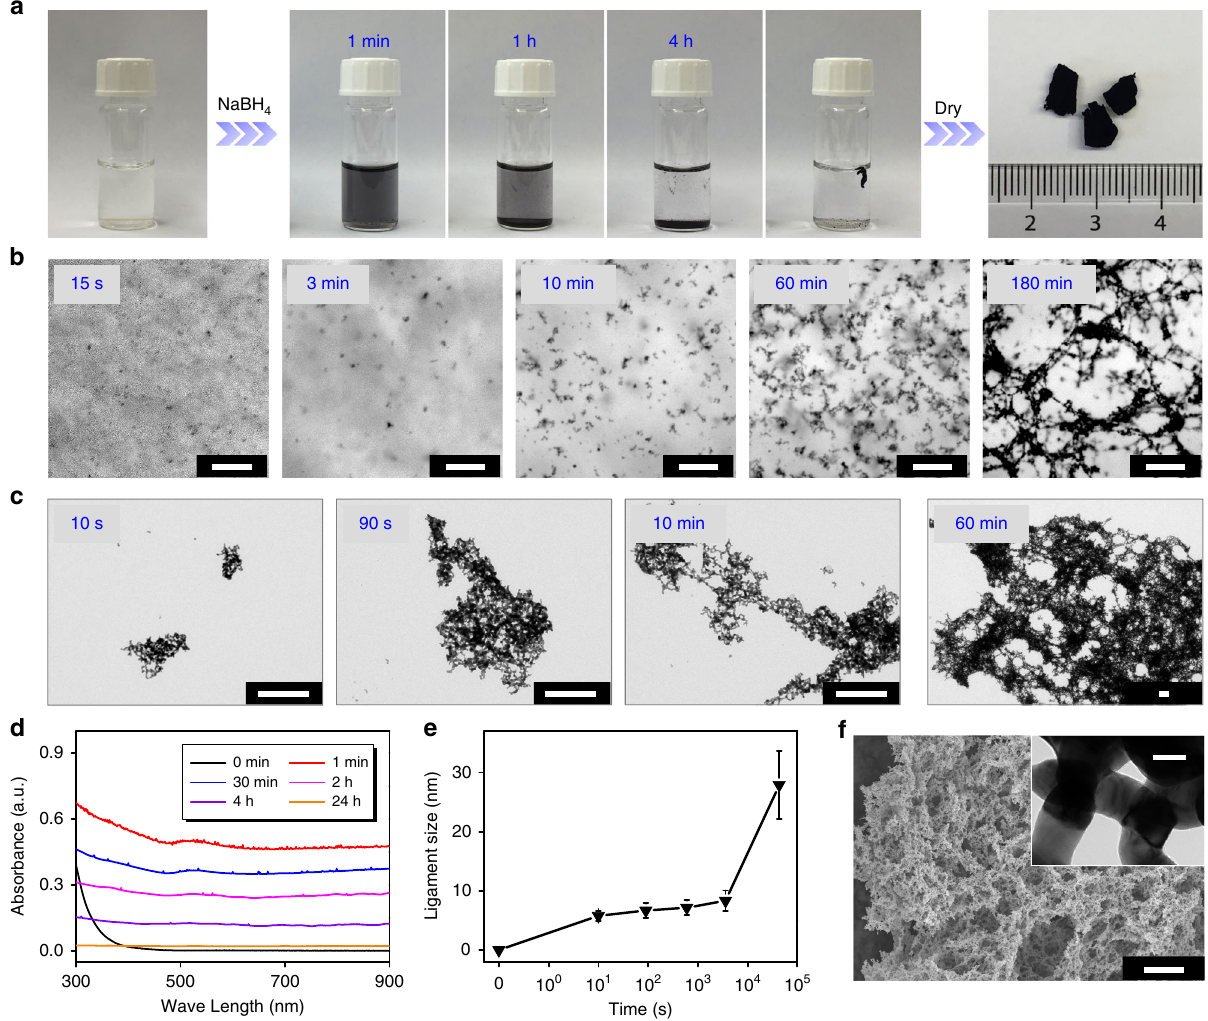
Fig. 1 Gelation process of gold NPs triggered by NaBH 4 . a Photographs of the fabrication process of the gold aerogel, where the wet gel was directly obtained from the HAuCl 4 aqueous solution (5 mL) and further freeze-dried to yield the corresponding aerogel. Note for a clear demonstration, the aerogels shown in Fig. 1a were prepared from ~800mL HAuCl 4 solution. Time-lapse b in situ optical microscopy, c ex situ TEM, and d UV-vis absorption spectra monitoring the gelation process. e Ligament size evolution of the gold aggregates during the gelation process (error bars depict the standard deviation). f SEM image and TEM image (inset) of the resulting gold aerogel. The scale bars in b , c , f , and the inset in f are 20 μ m, 200 nm, 10 μ m,